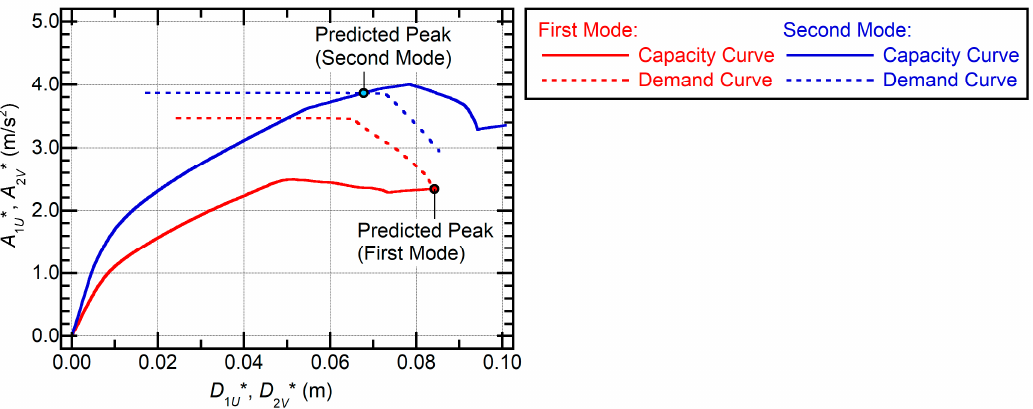
Figure 20. Prediction of the peak response for the first and second modal responses ( λ = C I, uni = 0.361).